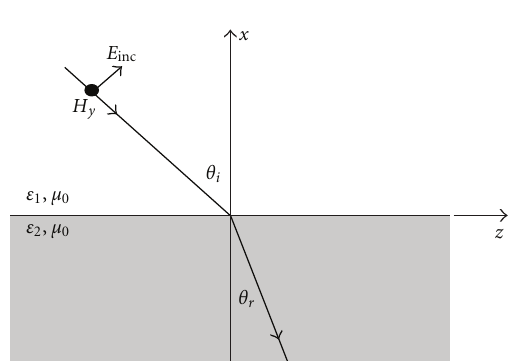
Figure 3: Diagram of a plane wave incident on a planar interface between two dielectric